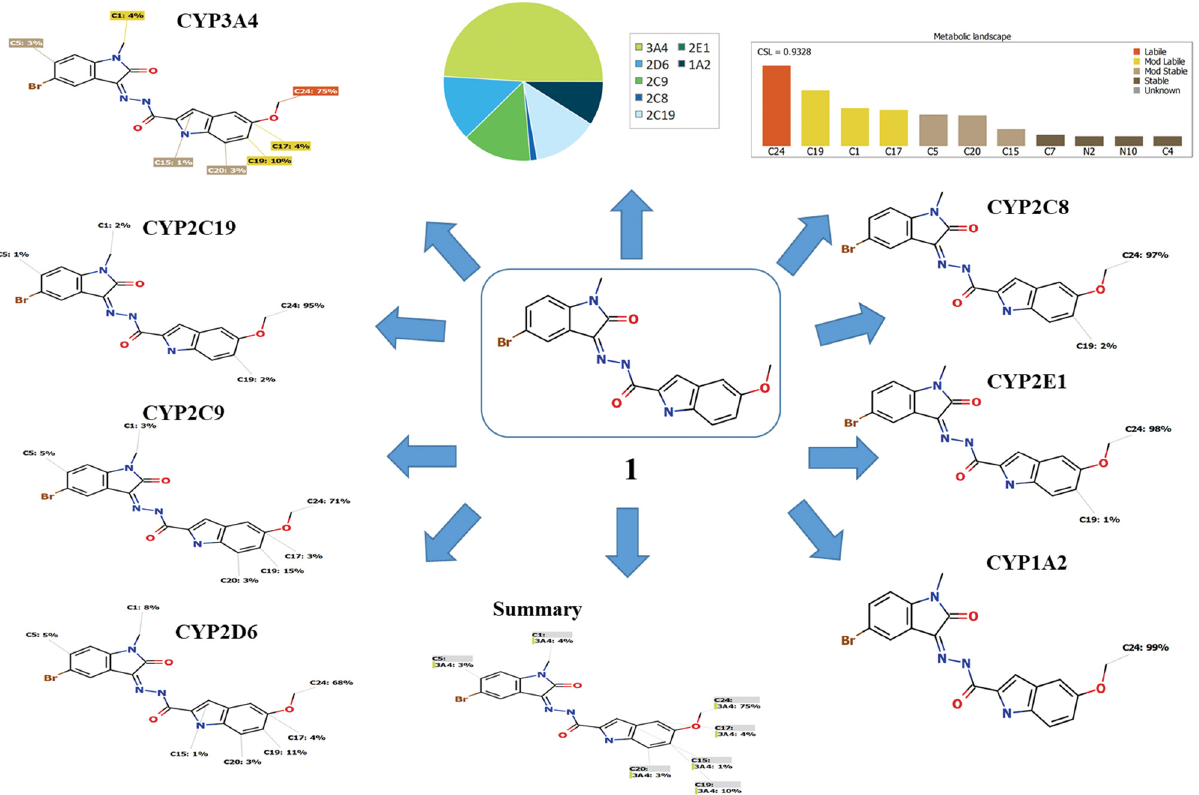
Figure 2: Proposed metabolic sites for compound 1 by the StarDrop WhichP450 ™ module. ( Metabolic landscape indicates the lability of C24 ( in the methoxy group ) , C17 and C19 ( in the indole moiety ) , and C1 ( in the N - methyl group ) in compound 1 is proposed to be labile for metabolism. CYP3A4 was proposed to have the main e ff ect in compound 1 metabolism. )